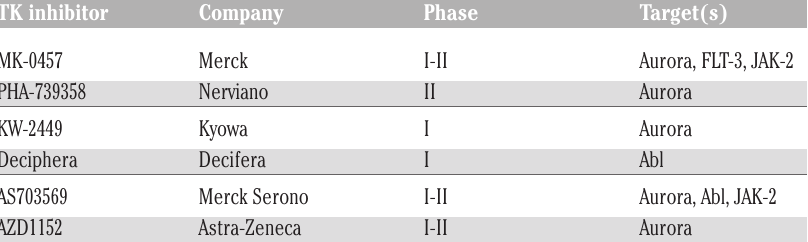
Table 2. Novel compound aurora-kinase inhibitors in clinical trial development.